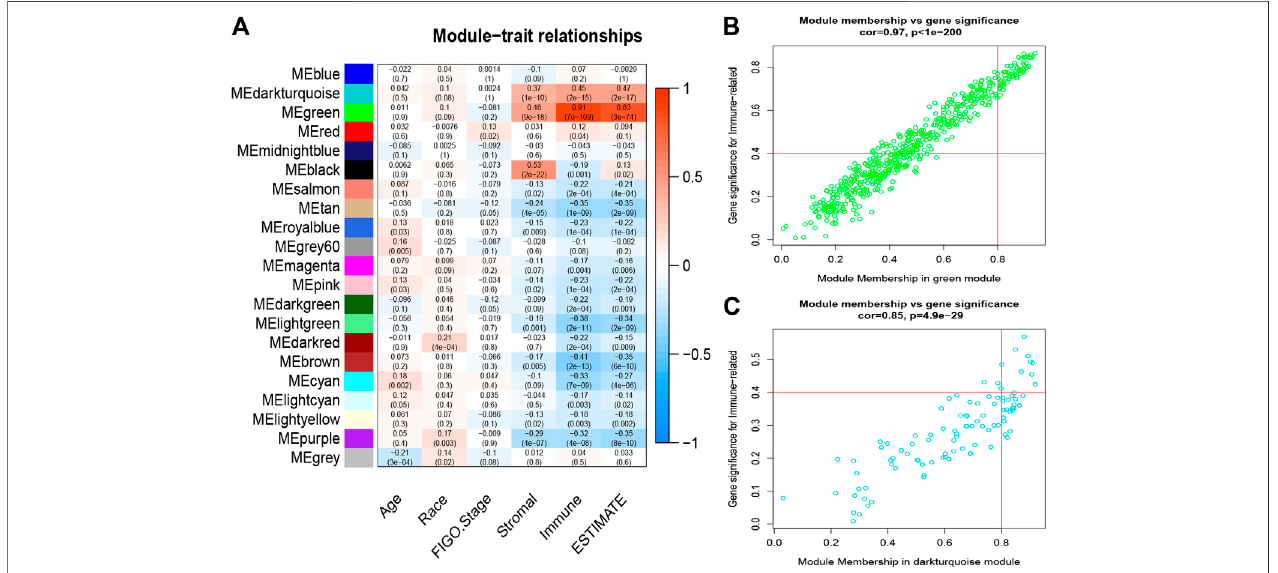
FIGURE4| Analysisofkeyimmune-relatedmodules. (A) ,Thecorrelationbetweenmodulesandtraitswasdisplayed. (B – C) ThecorrelationbetweenGSandMMin the green and dark-turquoise modules. GS, gene signi fi cance; MM, module membership.